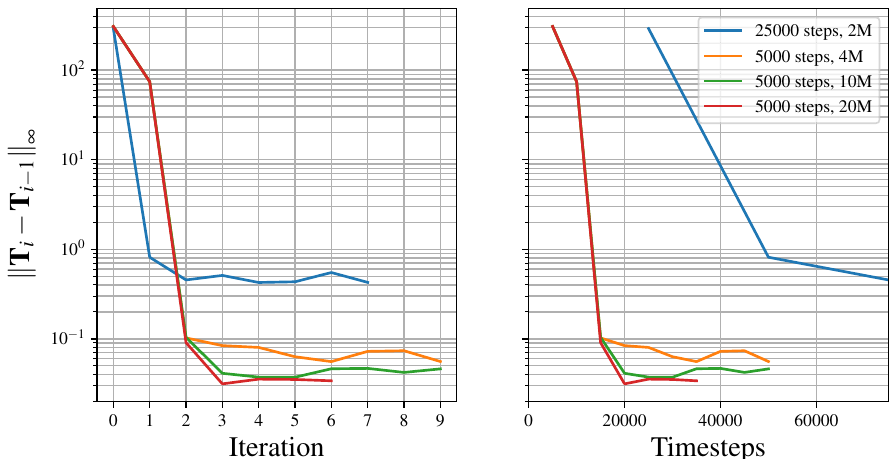
Figure 3: Convergence of the temperature distribution on the short model as a function of iterations (left) and Nek5000 timesteps